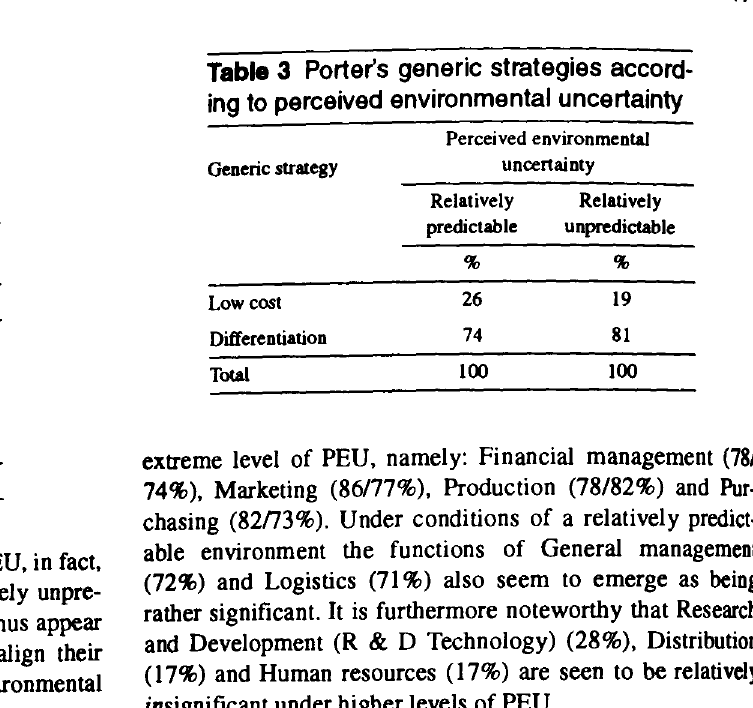
Table 3 Porter's generic strategies